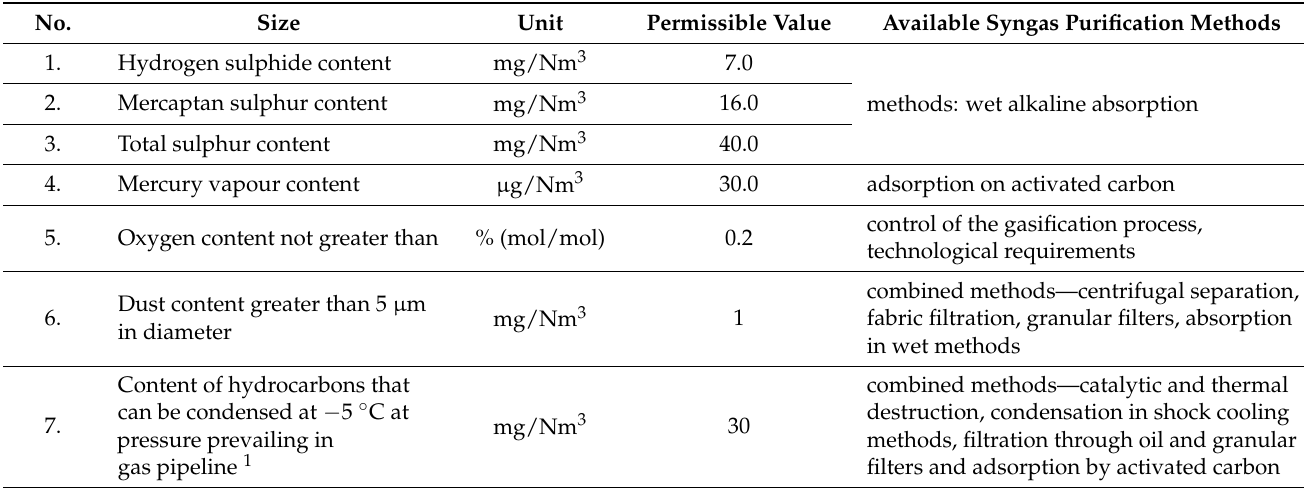
Table 1. Quality requirements for natural gas in accordance with applicable standards and methods of syngas purification